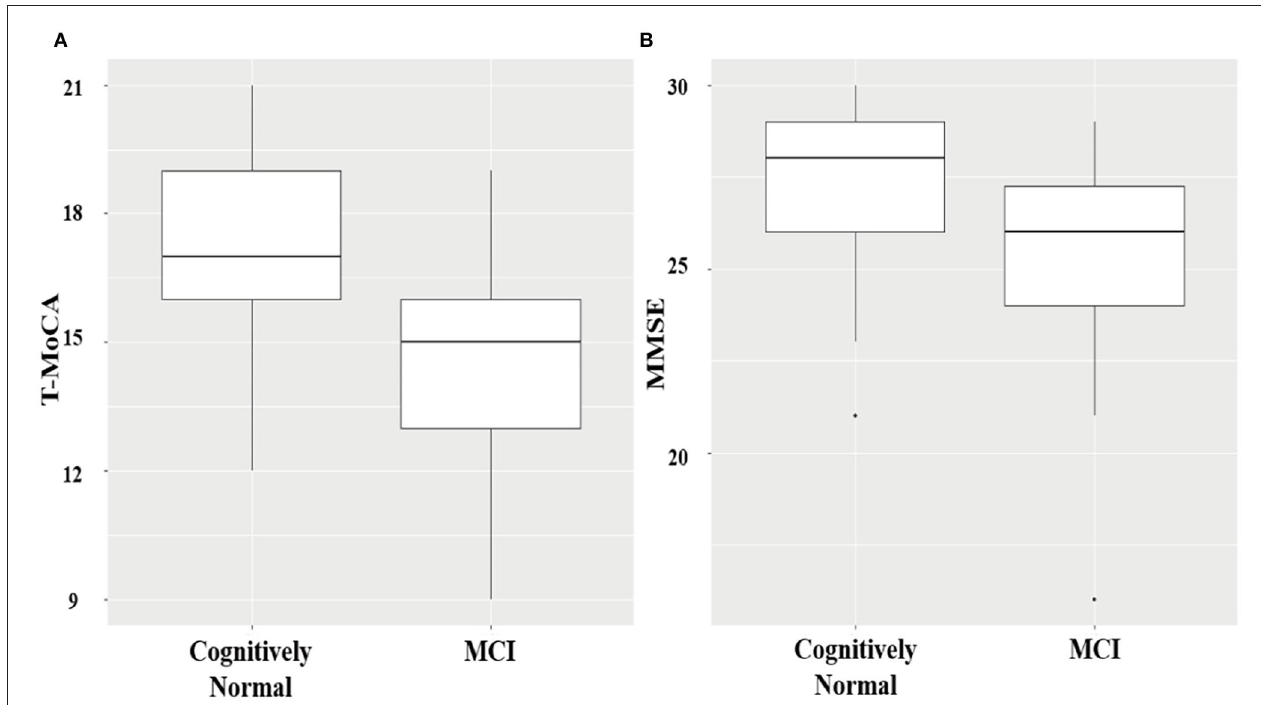
FIGURE 1 | Boxplots showing the distribution of T-MoCA (A) and MMSE scores (B) in MCI and cognitively normal patients.